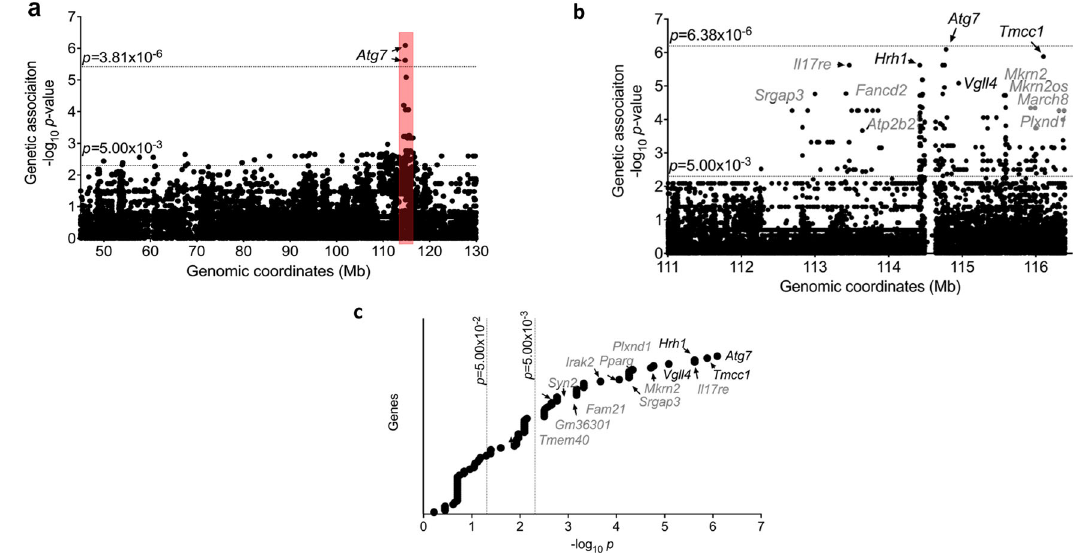
Fig. 2 Genetic association testing reveals candidates for Bphs. Bphs s was tested using a a low-resolution 13,257 SNP panel across Chr6:45.0-130.0 Mb followed by b a high-resolution 78,334 imputed SNP panel across Chr6:111.0-116.4 Mb. Both plots show negative log-transformed p -values of each SNP tested using Ef fi cient Mixed Model Association (EMMA) on the y-axis. Each fi lled circle denotes a single SNP. Signi fi cance thresholds are shown with a dotted line in each panel. The x-axis denotes Mb coordinates for Chr6 (mm10). c Gene names are included for SNPs that crossed p -value cut-off of 5.00 × 10 − 3